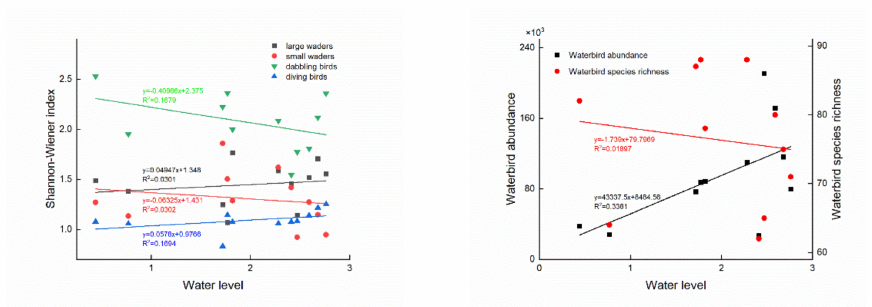
Figure 7. Effects of water level changes on waterbird abundance, waterbird species richness, and four waterbird